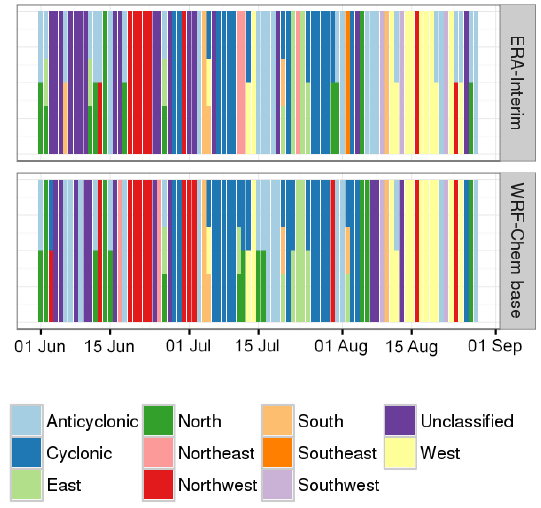
Figure 3. Comparison of weather types for Berlin calculated from ERA-Interim reanalysis data (top panel) and from WRF-Chem out- put from the domain with 15km horizontal resolution (bottom panel). Up to three weather types are calculated for each day.